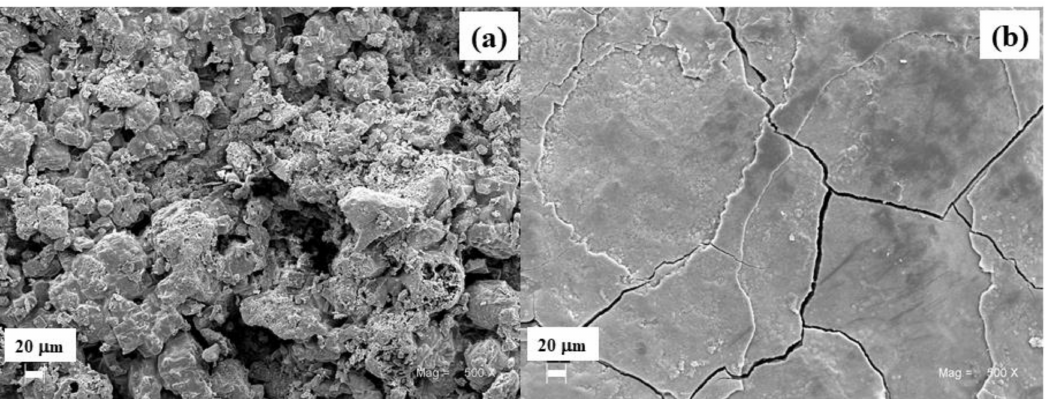
Figure 6. SEM images of corrosion products exposed for 36 months at the stations of ( a ) Arica and ( b ) Antarctic. Magnification 500 ×